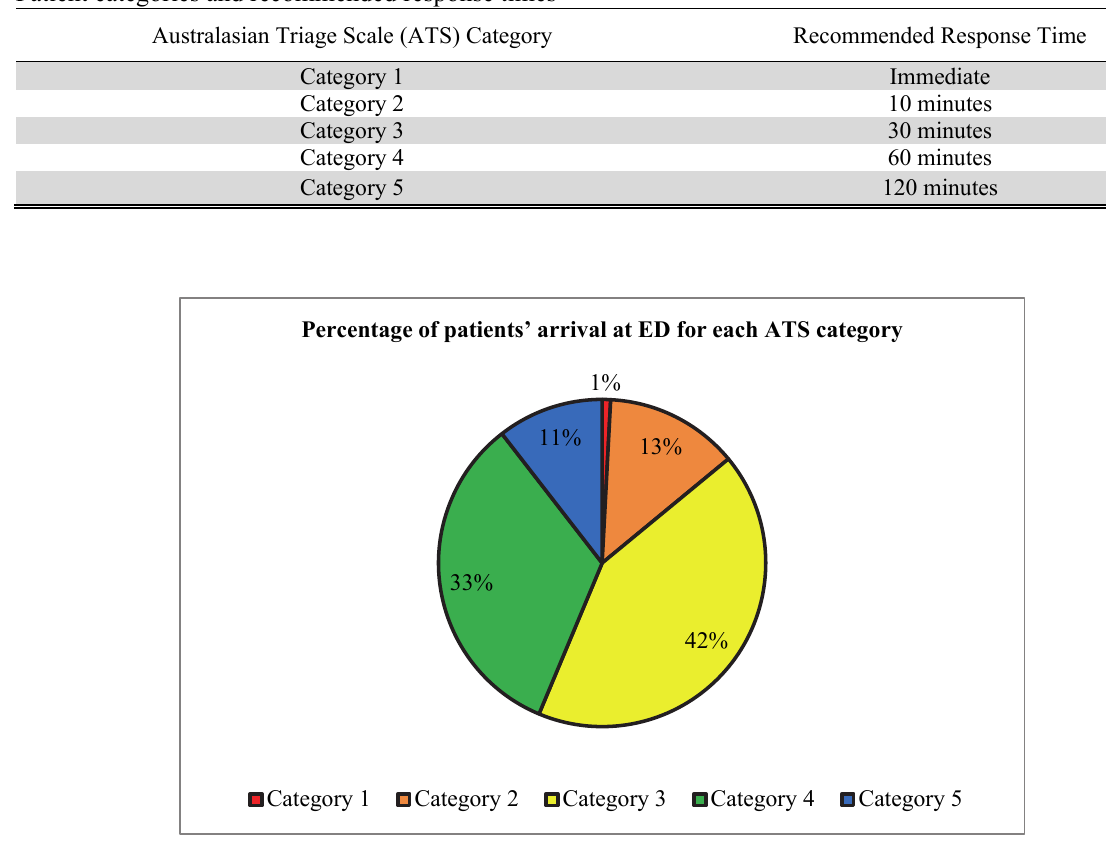
Fig. 9. Percentage of patients’ arrival for ATS